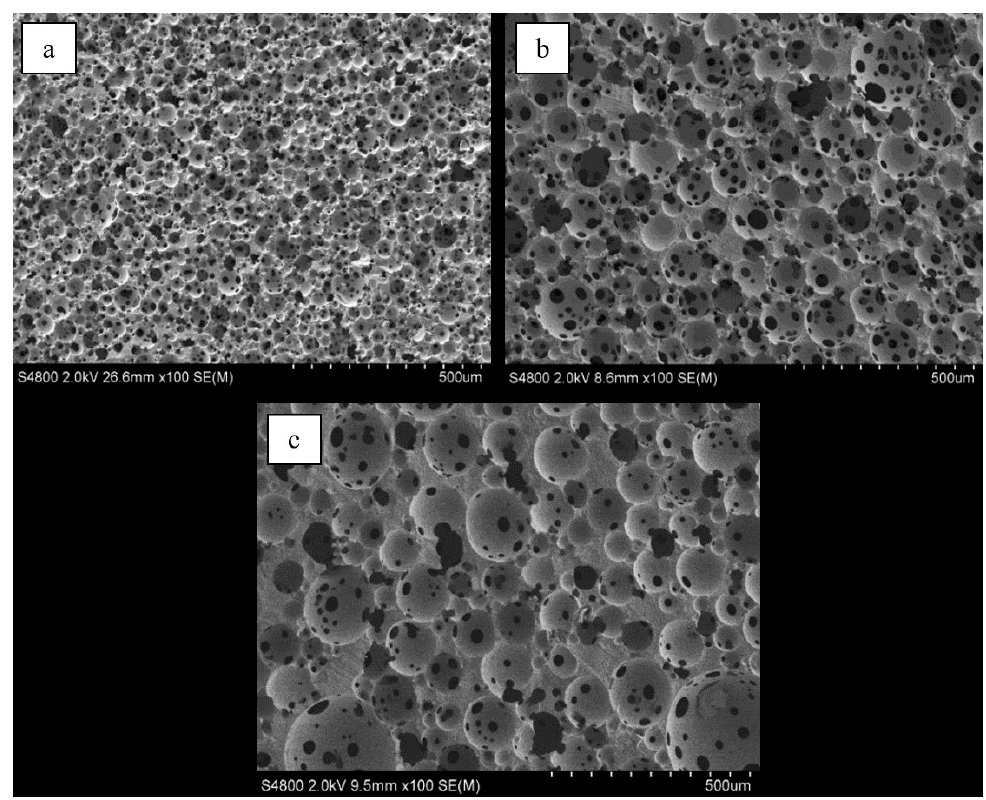
Figure 2. SEM micrographs of poly(TT/DPEHA)HIPEs with different Hypermer B246 concentrations. ( a ) 3.0 wt%; ( b ) 2.7 wt%; ( c ) 2.5 wt%.